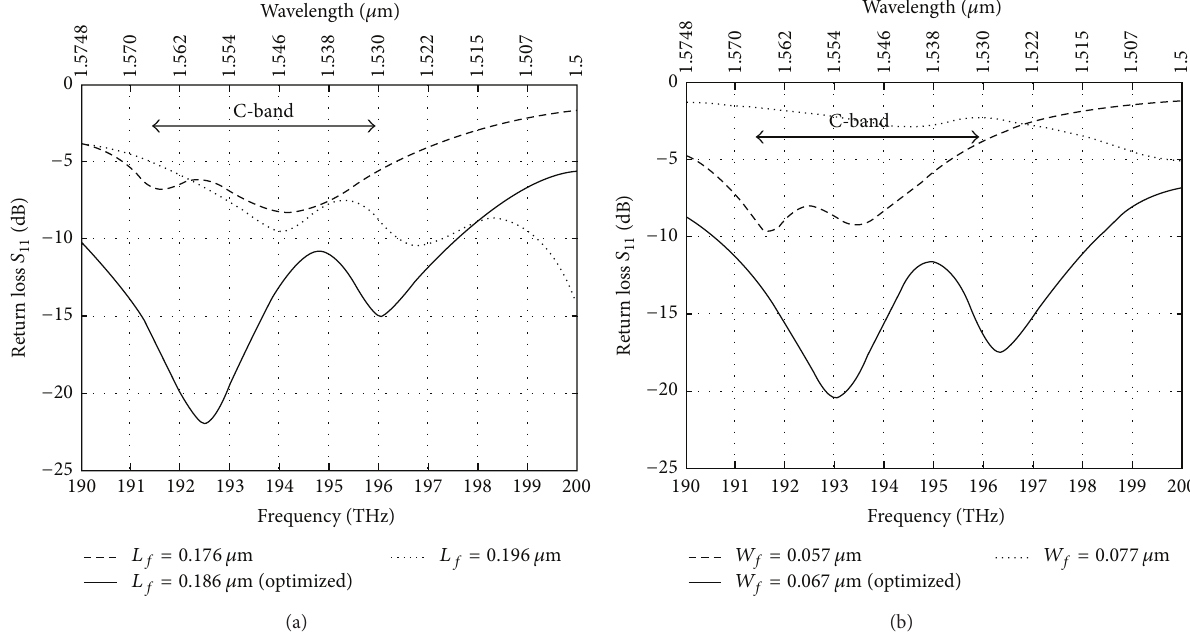
Figure 2: (a) Stub length with optimized values. (b) Width of the nanostrip feed with optimized